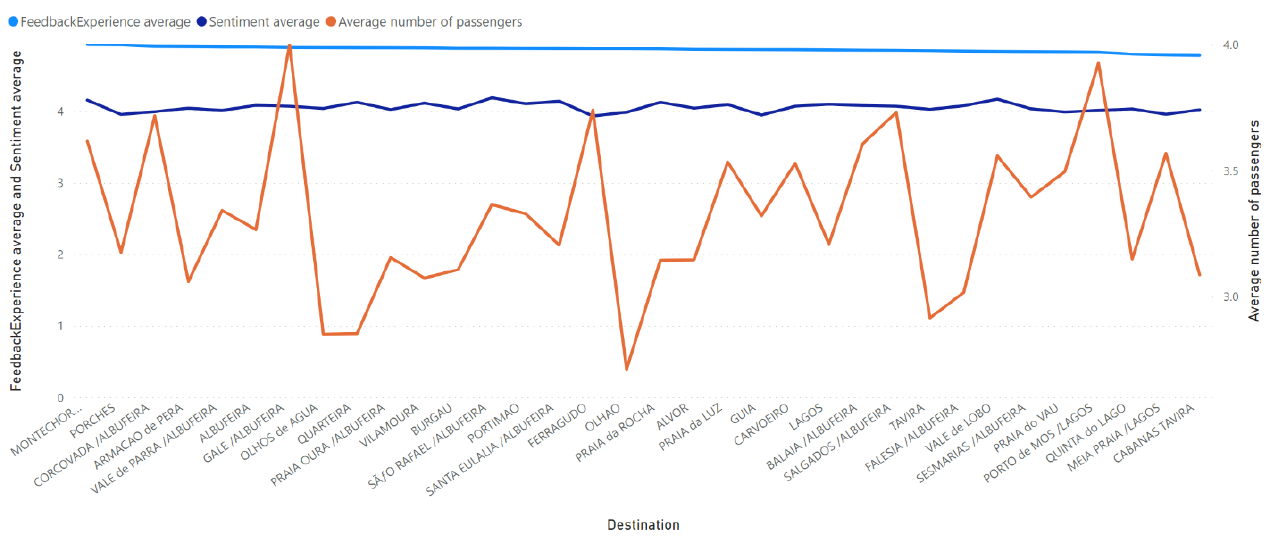
Figure 7. The normalised sentiment expressed in reviews, experience feedback, and the average number of passengers performed for destinations that account for at least 50 services. The distance covered can also be an analysis factor for a tourist transport